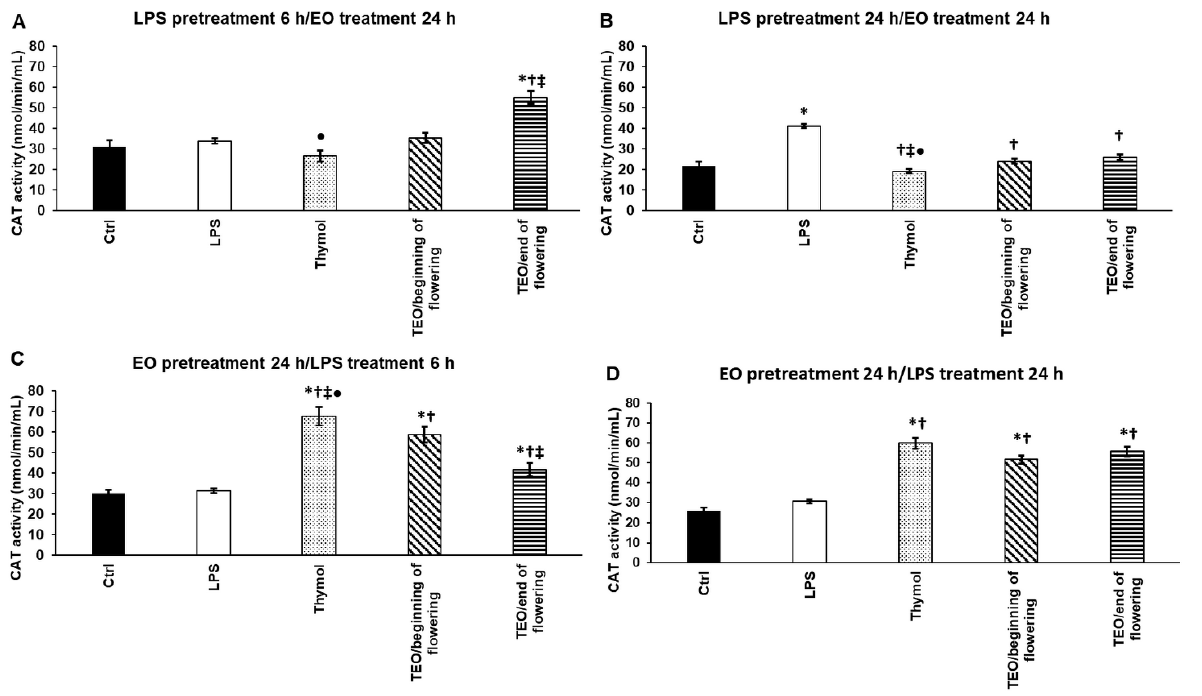
Figure 4. Determination of the effects of thymol and TEOs on catalase (CAT) activity of the THP-1 cells. As a control, the THP-1 cells were treated with DMSO, the carrier of EOs or distilled water, and the solvent of LPS in the same order and for the same time as in the case of the EO and LPS pretreatments. For LPS treatment, the cells were treated with LPS for 6 h or 24 h, and then they were treated with 500-fold diluted DMSO for 24 h, or they were treated with DMSO for 24 h, and then they were treated with LPS for 6 h and 24 h. For LPS pretreatment, the cells were treated with LPS for 6 h and 24 h, and then they were treated using 500-fold diluted thymol or TEOs for 24 h. For EO pretreatment, the cells were treated with 500-fold diluted thymol or TEOs for 24 h followed by LPS treatments for 6 h and 24 h. CAT activity was determined using Catalase Assay kit according to the protocol of the manufacturer and was expressed as nmol/min/mL. The bars represent mean values, and error bars represent standard deviation (SD) for three independent experiments (n = 3). The assays were carried out in triplicate in each experiment. Asterisk indicates p < 0.05 compared to control. Cross marks p < 0.05 compared to LPS treatment. Double cross shows p < 0.05 compared to TEO/beginning of flowering. Bullet marks p < 0.05 compared to TEO/end of flowering. Statistical analysis was carried out by two-way ANOVA followed by Scheffe’s post hoc test.